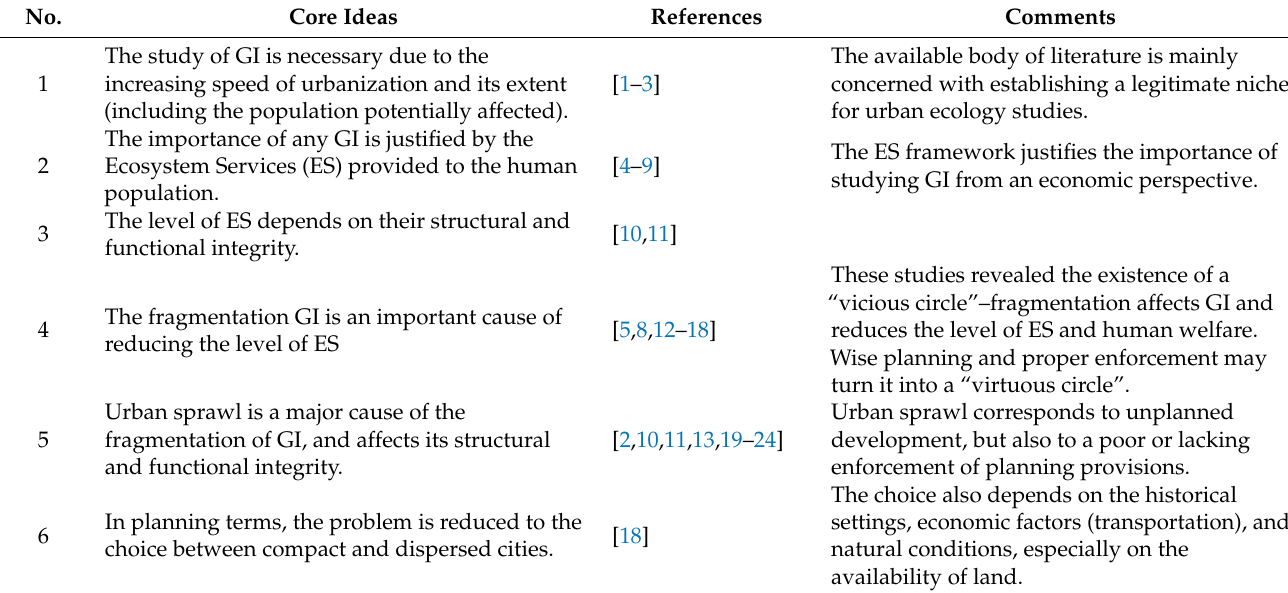
Table 1. The commonly agreed body of knowledge on the importance of